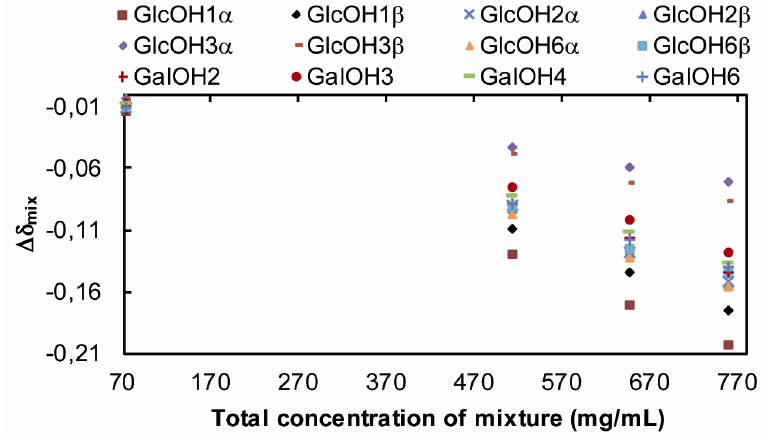
Figure 7. Δδ values for the hydroxy protons of lactose in trehalose/lactose/water mix solutions as a function of the total sugar